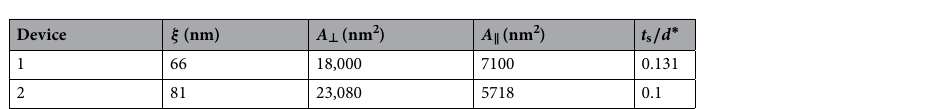
Table 1. Model parameters used to fit data of Devices 1 and 2 in Figs. 2 and 3. From left to right, coherence length ( ξ ), effective perpendicular flux parameter ( A ⊥ ), effective parallel flux area ( A (cid:31) ), and ratio of shell thickness ( t s ) to effective single cylinder diameter ( d ∗ ). For parameter extraction methods, see Methods.